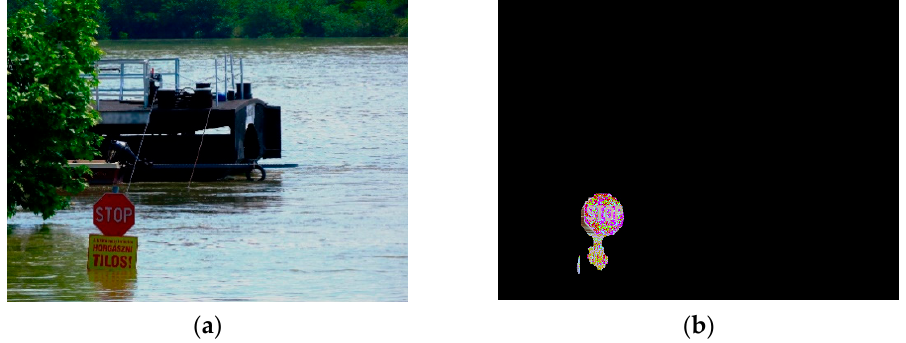
Figure 9. Illustration of the multi-object scenario: ( a ) input image; ( b ) output image.